Question: How would you classify this visualization?
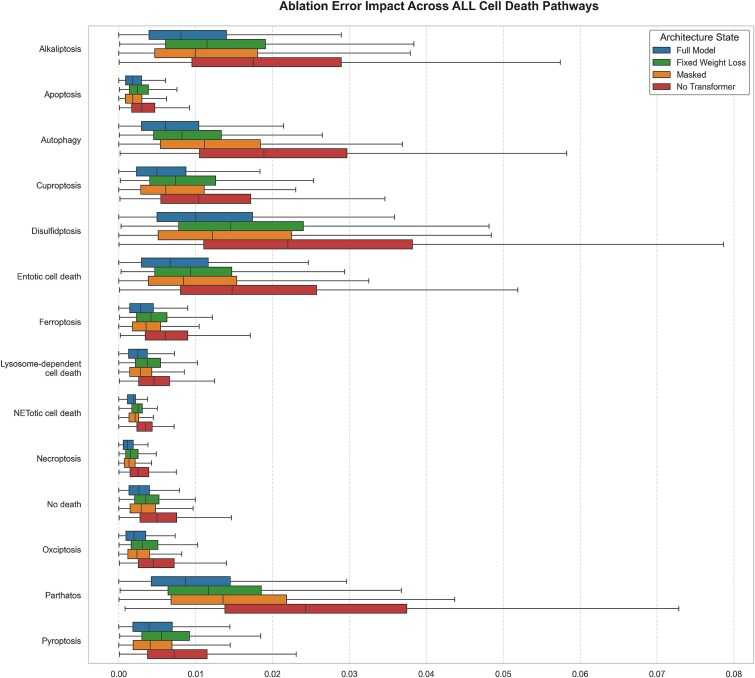
Answer: box